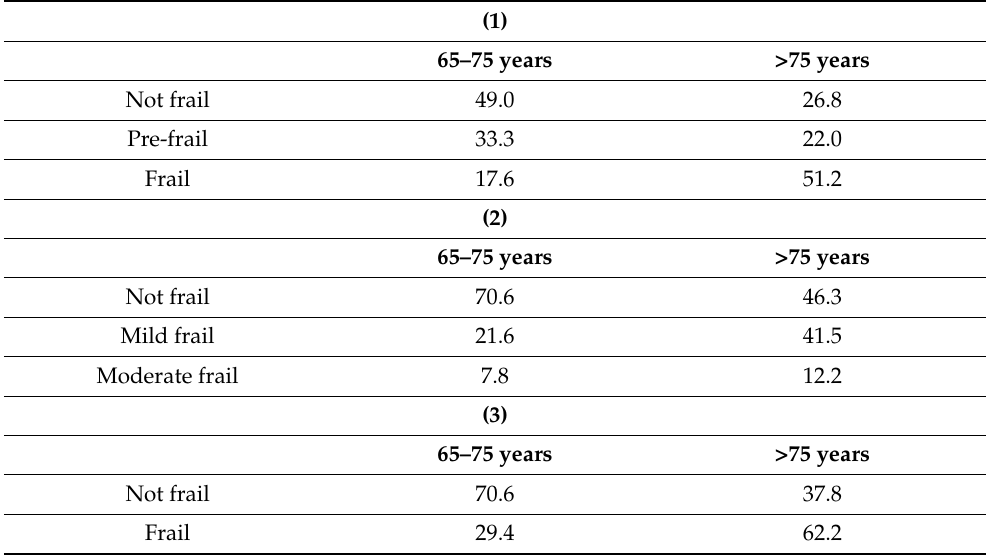
Table A4. (1) Frailty analysis (in %) according to the Fried phenotype per age group ( p < 0.001). (2) Frailty analysis (in %) according to the Vigorito frailty assessment tool per age group ( p = 0.022). (3) Frailty analysis (in %) according to the newly developed frailty assessment tool per age group ( p <